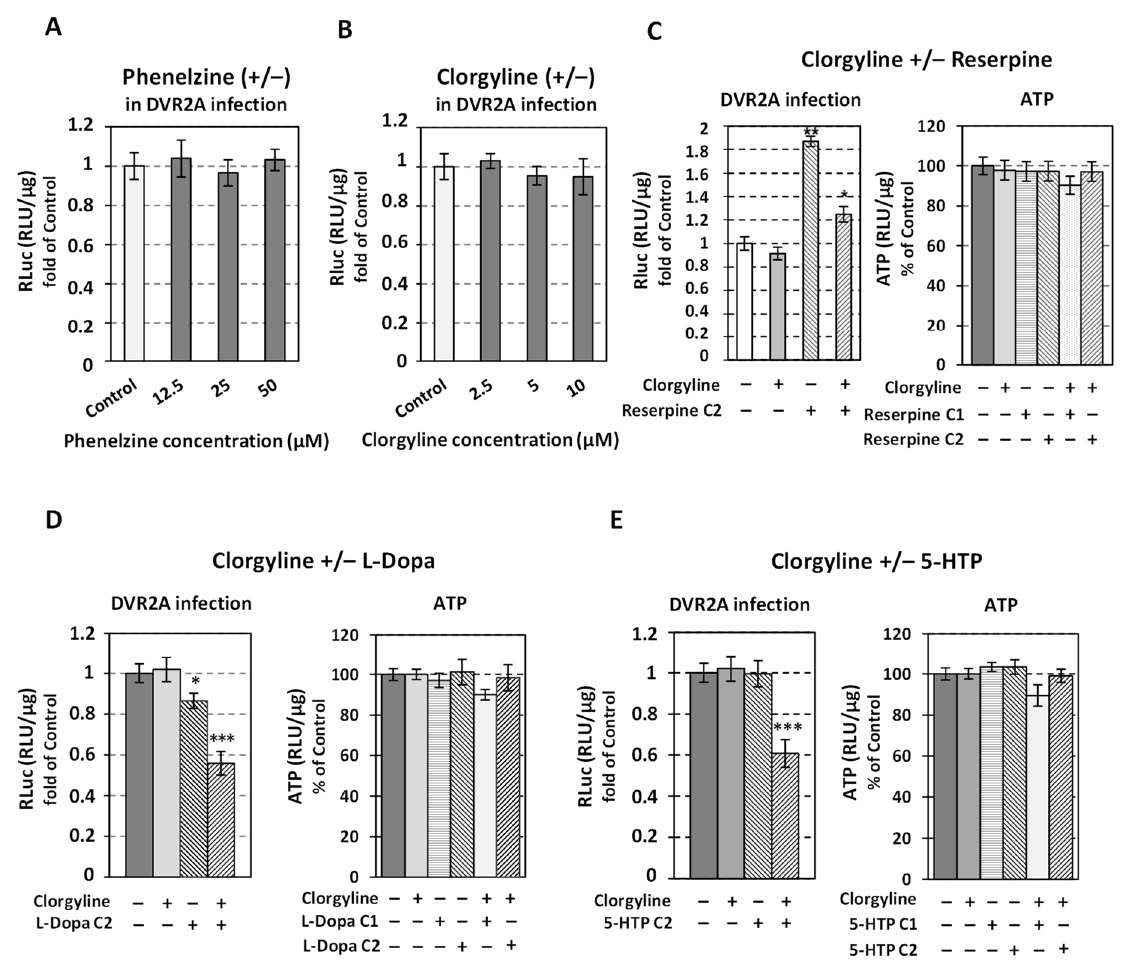
Figure 8. Elevated catecholamine levels make DV replication sensitive in MAO inhibitors. Effect of non-cytotoxic concentrations of MAO inhibitors on DV replication. (( A – E ) left panels): After a 4 h inoculation of Huh7 cells with DVR2A (MOI = 0.1), cells were treated with different concentrations of MAO inhibitors ( A , B ), or co-treated with clorgyline and reserpine ( C ), clorgyline and L-Dopa ( D ), clorgyline and 5-HTP ( E ), or were mock-treated (Control, ( − )), for 48 h. Cells were then lysed and levels of Renilla luciferase activity were measured. Control cell values were set as one. (( C – E ) right panels): Intracellular ATP levels were determined. Mock-treated cell (Control, ( − )) values were set as 100%. For Clorgyline = 5 µ Μ , Reserpine: C1 = 2.5 µ Μ , C2 = 1.25 µ Μ , L-Dopa: C1 = 30 µ Μ , C2 = 15 µ Μ and for 5-HTP: C1 = 50 µ Μ , C2 = 25 µ Μ . In all panels, the mean values ± standard deviations from three independent experiments in triplicate are presented. * p < 0.05, ** p < 0.01, *** p < 0.001 vs. Control ( − ).